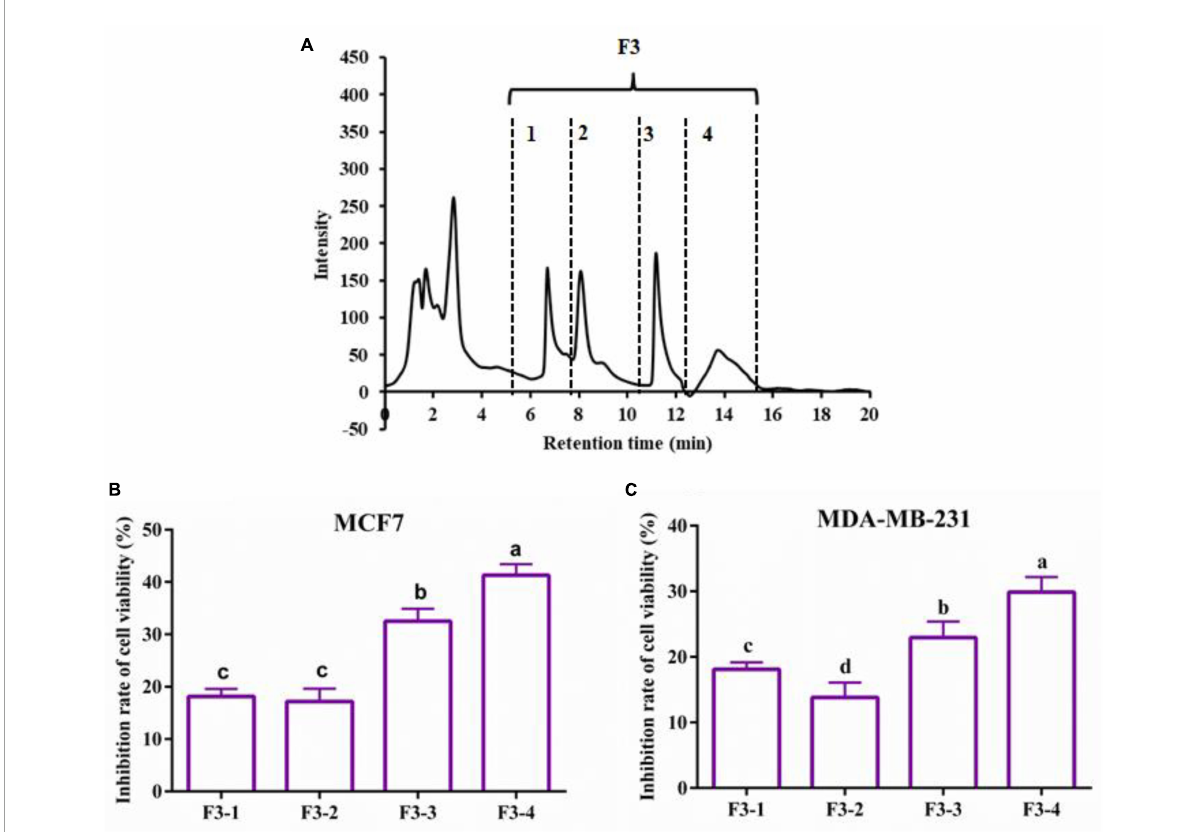
FIGURE3 Reversed phase high-performance liquid chromatography chromatogram of F2 fraction (A) and the cell viability inhibition rate of subfractions against MCF7 cells (B) and MDA-MB-231 cells (C) . Both cancer cells were treated with 0.2 mg/mL of various subfractions (F3-1 ∼ F3-4) for 48 h. The inhibitory effects of subfractions on the two breast cancer cells were evaluated by